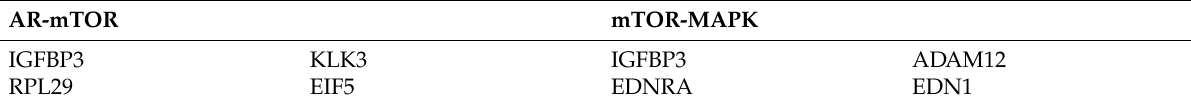
Table 2: Common inter-pathway connections between STRING and GeneMANIA for all three pathways. AR-mTOR mTOR-MAPK IGFBP3 EIF5